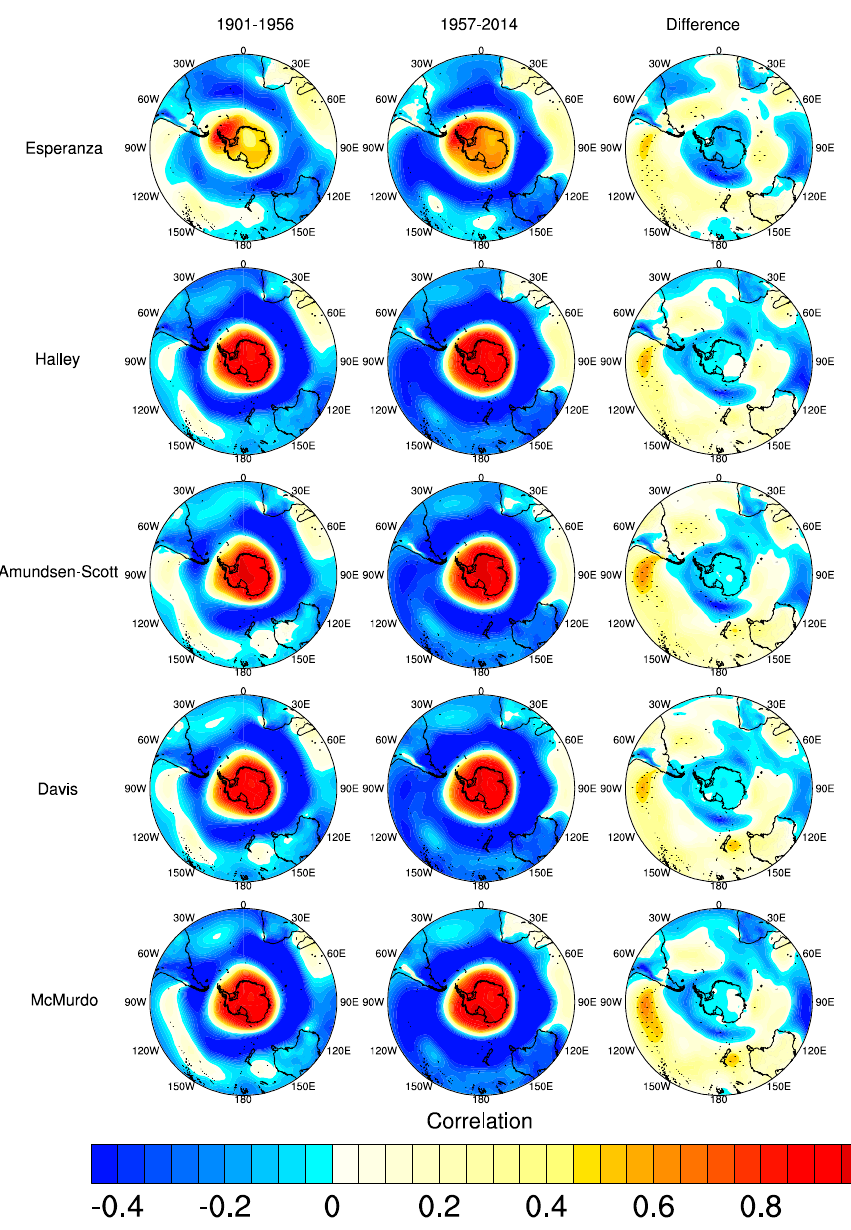
Figure 4. Station correlations of 5 locations in Antarctica (Esperanza, Halley, Amundsen-Scott, Davis and McMurdo) to the surrounding high- and mid-latitudes in CAM5. Time periods represent the validation period (1901–1956), calibration period (1957–2014) and a difference of the two (early–late). Stippling on the difference plot indicates regions that are statistically different ( p < 0.05 ) from the early period compared to the late period. Ensemble six of the Ozone Only experiment was chosen to represent the overall pattern within CAM5.